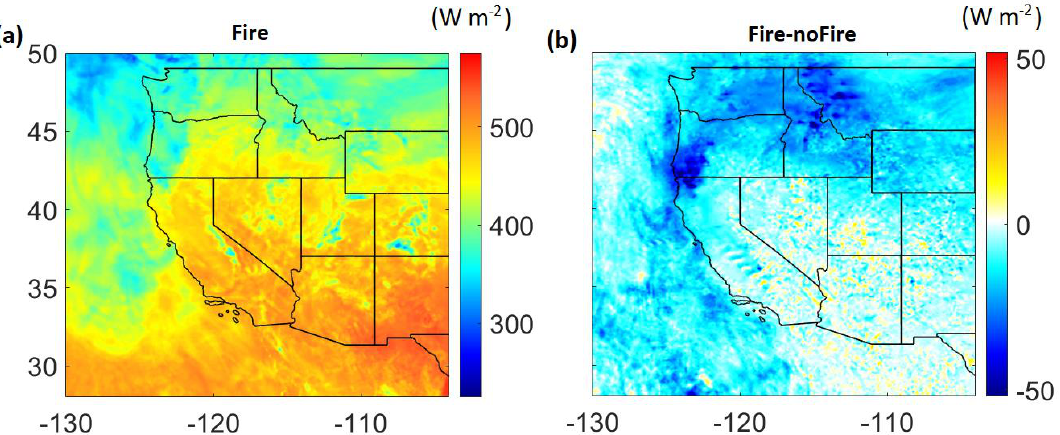
Figure 7. Spatial distribution of daytime average ( a ) shortwave downward surface radiation in W m −2 from ‘Fire’ simulation and ( b ) difference between ‘Fire’ and ‘noFire’ simulations for the first half of September 2017.